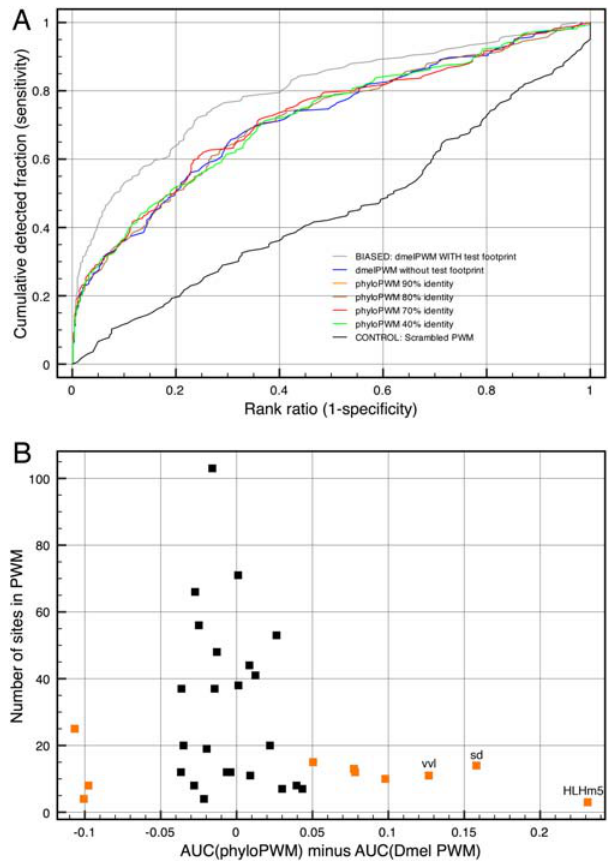
Figure 4. Homotypic cluster detection with phyloPWMs. (A) LOOCV performance for Dmel PWMs (blue curve), and phyloPWMs from all species tested ( Dmel, Dsim, Dsec, Dere, Dyak, Dana, Dpse, Dper, Dvir, Dmoj, and Dgri ). Orthologous sites were chosen based on a minimum of either 40% (green curve), 70% (red), 80% (brown), or 90% (orange) identity with the Dmel true binding site. (B) Differences between the AUC values obtained from a Dmel PWM and a phyloPWM, for each TF. TFs with differences above 0.05 are colored orange. PWMs with few sites (y-axis) have greater AUC differences than PWMs with many sites.